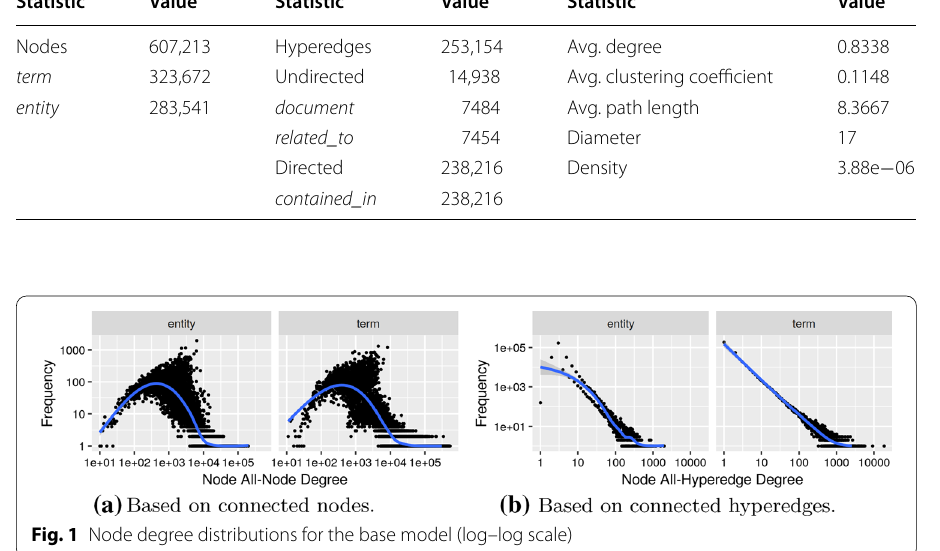
Table 2 Global statistics for the base model Statistic